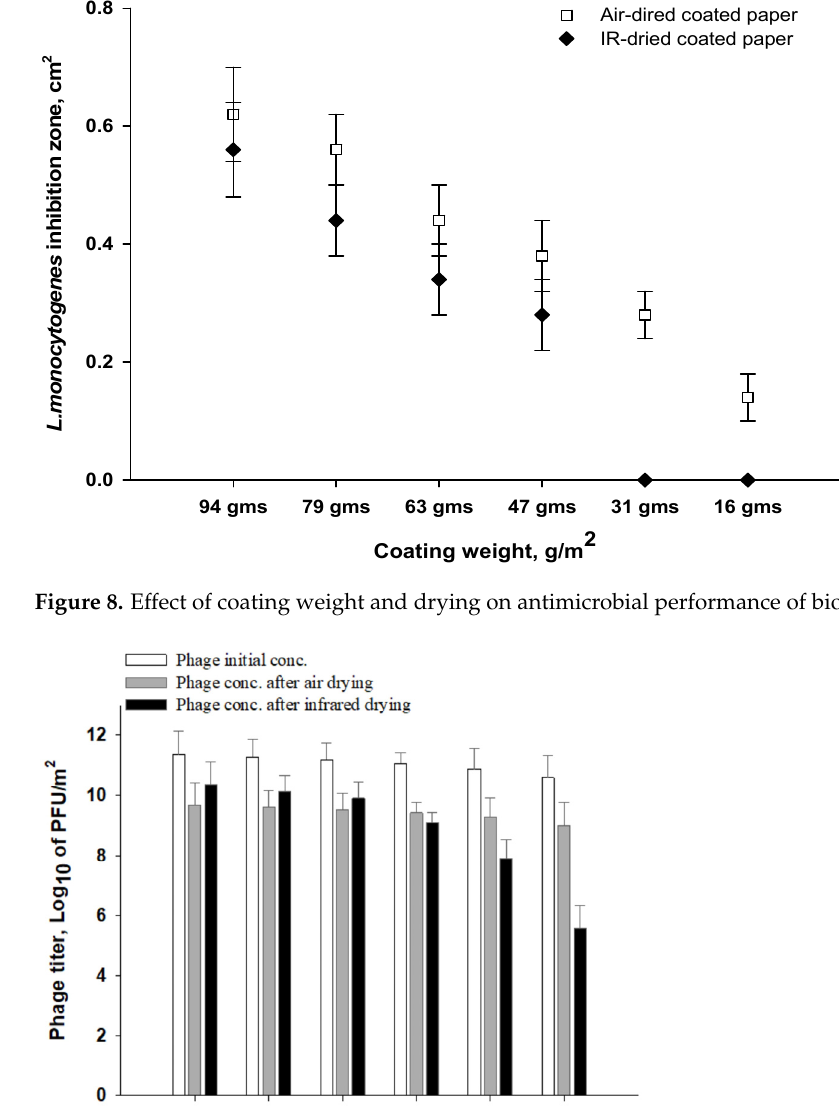
Figure 7. Temperature profile detected on the surface of coated papers at different coating weights (g/m 2 ) during infrared drying .